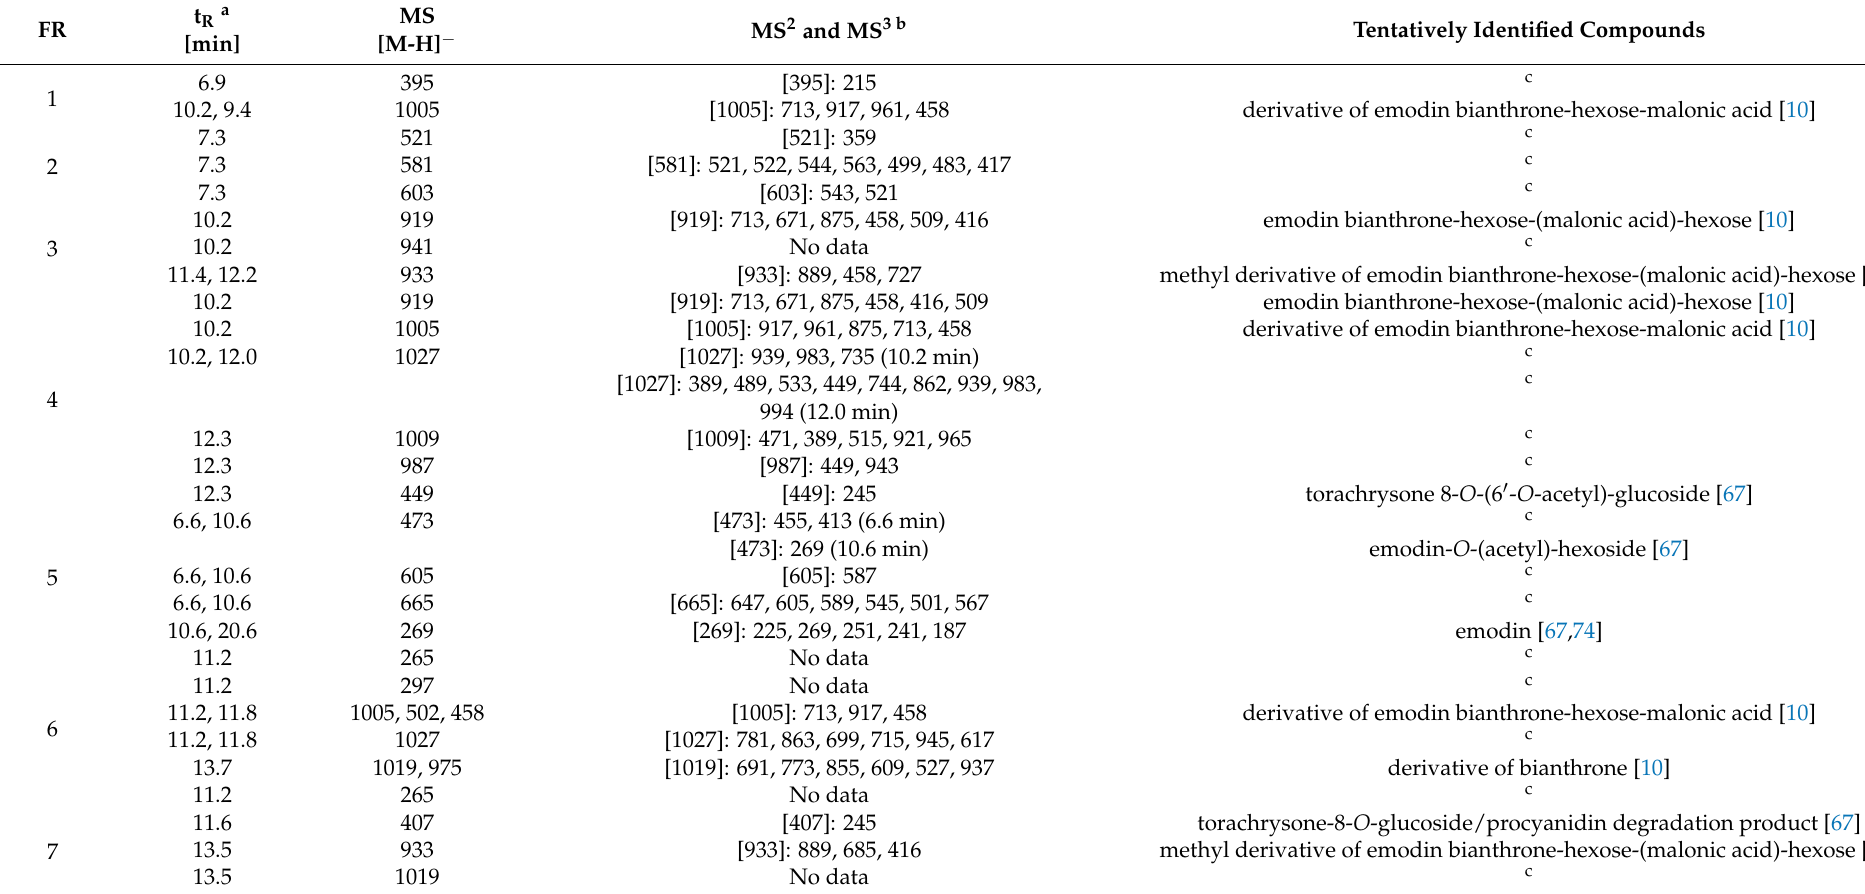
Table 3. RP-HPLC-MS analysis of the compounds in the SEC-HPLC-UV fractions (FR 1–FR 14), corresponding to the SEC t R ranges (FR 1: 7.7–8.0, FR 2: 8.3–8.6, FR 3: 9.3–9.8, FR 4: 11.0–11.7, FR 5: 13.0–13.4, FR 6: 13.6–15.0, FR 7: 16.1–16.6, FR 8: 16.8–18.0, FR 9: 19.4–19.8, FR 10: 20.8–22.9, FR 11: 24.0–25.5, FR 12: 26.4–27.8, FR 13: 28.7–30.2, and FR 14: